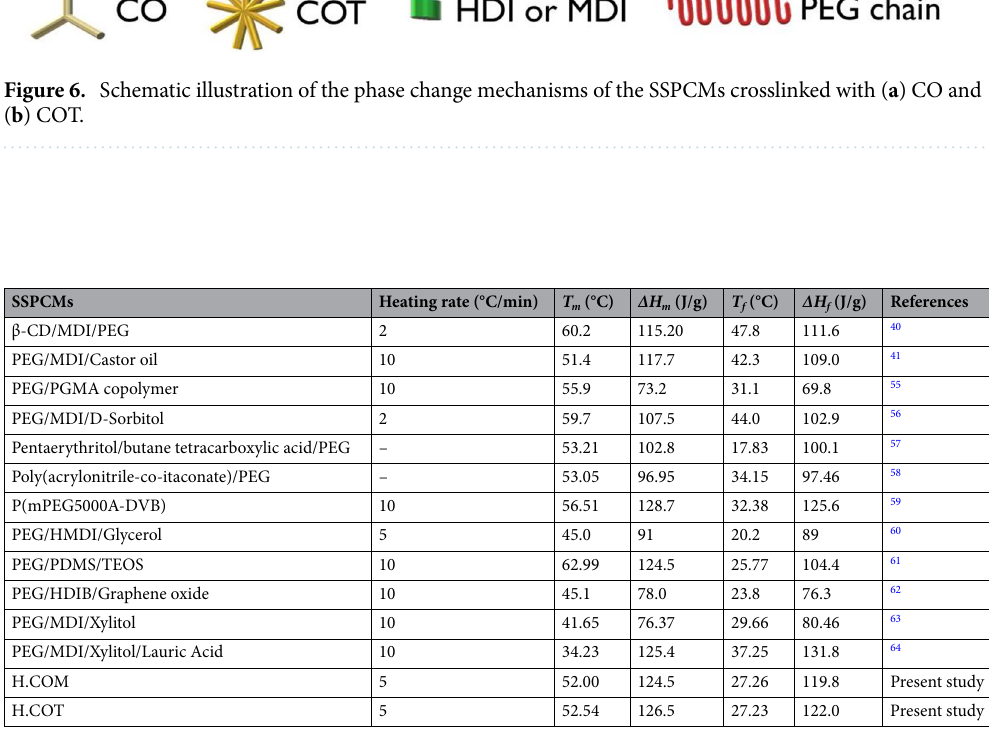
Table 3. Comparison of thermal properties of the crosslinked polymeric SSPCMs in